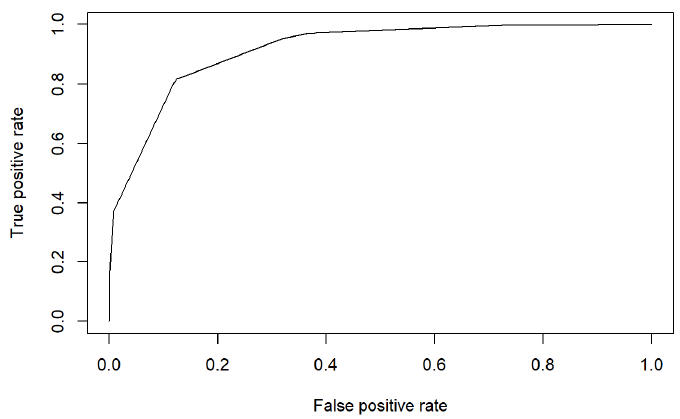
Figure 7. ROC 2 of the estimated model.